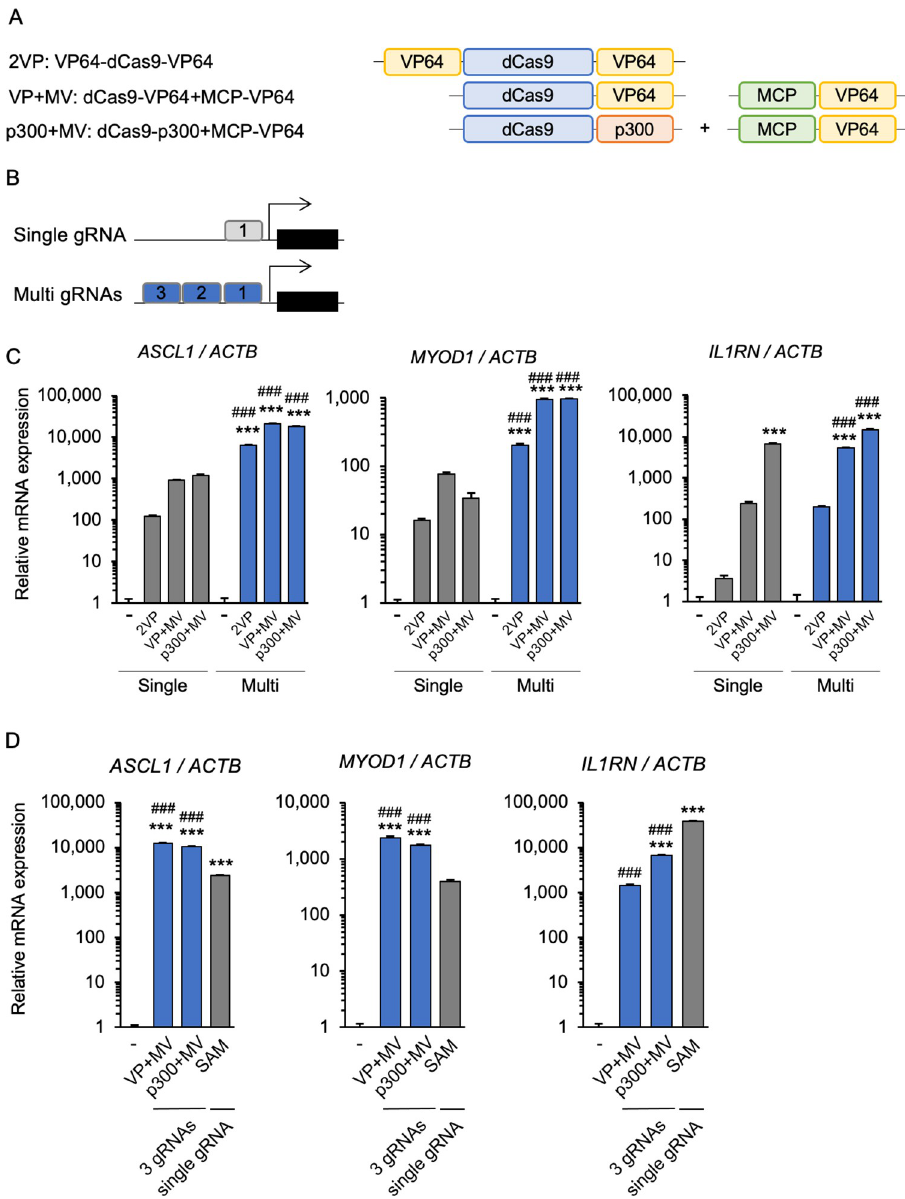
Fig 4. Analysis of the impact of multiplexing gRNAs targeting a single gene. (A) Schematic diagrams of CRISPRa systems used for gRNA multiplexing to target single genes. (B) Schematic diagrams show the positions of single and multiple gRNAs near the transcriptional start site. (C) Expression of three endogenous genes in the presence of a single gRNA or multiple gRNAs in human HEK293T cells. Multiplexed gRNAs enhanced transcription in all three systems tested. Error bars indicate the mean ± SE (n = 3). Statistical analysis was performed using one-way ANOVA with Tukey’s multiple comparisons test. ��� , P < 0.005 vs. non-induced control, ### , P < 0.005 vs. the level observed for each corresponding single gRNA experiment. (D) Expression of three endogenous genes were tested in CRISPRa- transfected human HEK293T cells. VP+MV and p300+MV with multiple gRNAs showed higher ASCL1 and MYOD1 activation than SAM with a single gRNA. For induction of IL1RN , VP+MV and p300+MV with multiple gRNAs did not reach the activity of SAM with a single gRNA. Statistical analysis was performed using one-way ANOVA with Tukey’s multiple comparisons test. ��� , P < 0.005 vs. non-induced control, ### , P < 0.005 vs. SAM.